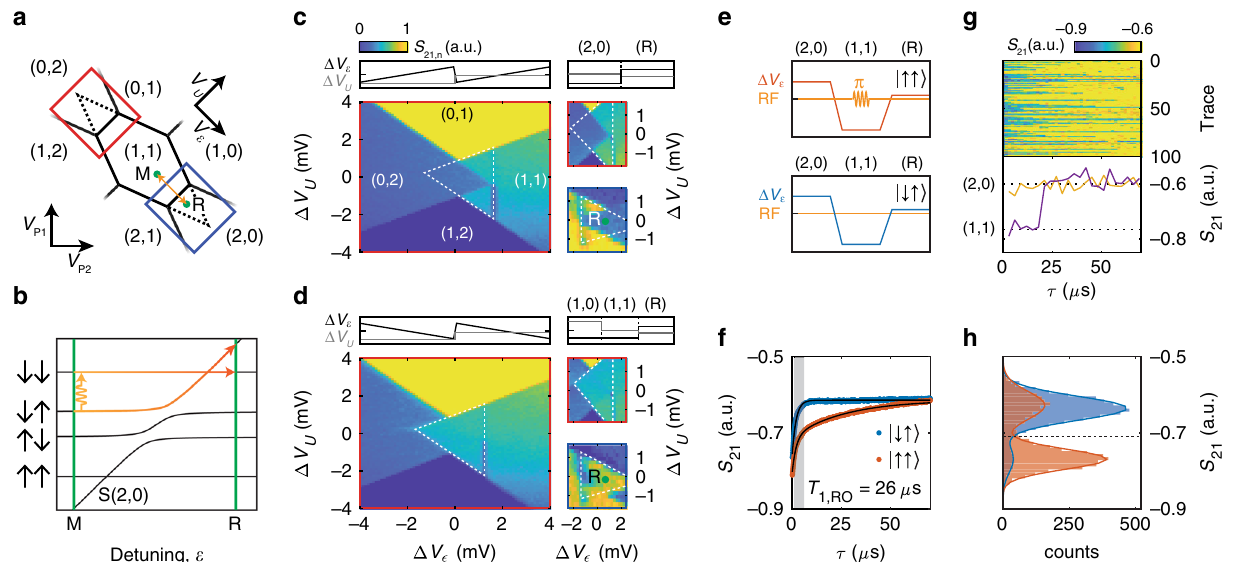
Fig. 2 Single-shot spin readout of a single hole. a Schematic of a typical hole charge stability diagram with both possible regions of readout indicated in blue and red. The typical manipulation (M) and readout (R) points are indicated in green. b Two-hole energy diagram, with the fi ve lowest lying energy states around the (1,1)-S(2,0) anticrossing. c Colour map of the normalised sensor response (normalisation in Methods) as a function of the applied gate voltages V U and V ϵ . In the large panel, we linearly sweep V ϵ and step V U , as indicated in the inset above the fi gure. The smaller panels on the right show the same effect for the (1,1)-(0,2) anticrossing (top, red box in a ), and the (1,1)-(2,0) anticrossing (bottom, blue box in a ), now using a two-level voltage pulse (details in Methods). d Similar colour map as in c , but with a reversed sweeping direction from (1,1) to the (0,2) region. The triangular spin blockade window is indicated by the dashed white line. The smaller panels on the right again demonstrate the same effect for both the (1,1)-(0,2) (top) as well as the (1,1)-(2,0) (bottom) anti-crossings, by fi rst loading a random spin in one of the dots (details in Methods). e Schematic illustration of the three-level pulses used in f – h , indicating the detuning voltage Δ V ϵ in blue and red, and the RF-pulses in orange. f The averaged charge sensor response as a function of measurement time τ at R for ""j i initialisation (red) and #"j i initialisation (blue). The grey-shaded area indicates the integration window for the threshold detection. g A sample of 100 single-shot traces (top), averaged for 3 μ s per data point, with τ = 0 the start of the readout phase. The bottom panel shows two single traces, where the purple (yellow) trace corresponds to the readout of a blocked (not blocked) spin state. Dashed lines correspond to the sensor signal for the different charge states. h Histogram of 5000 single-shot traces, integrating the signal for 5.5 μ s as indicated in f . The blue (red) histogram corresponds to an initialisation in the #"j i ( ""j i ) state. The dashed line corresponds to the optimised threshold for